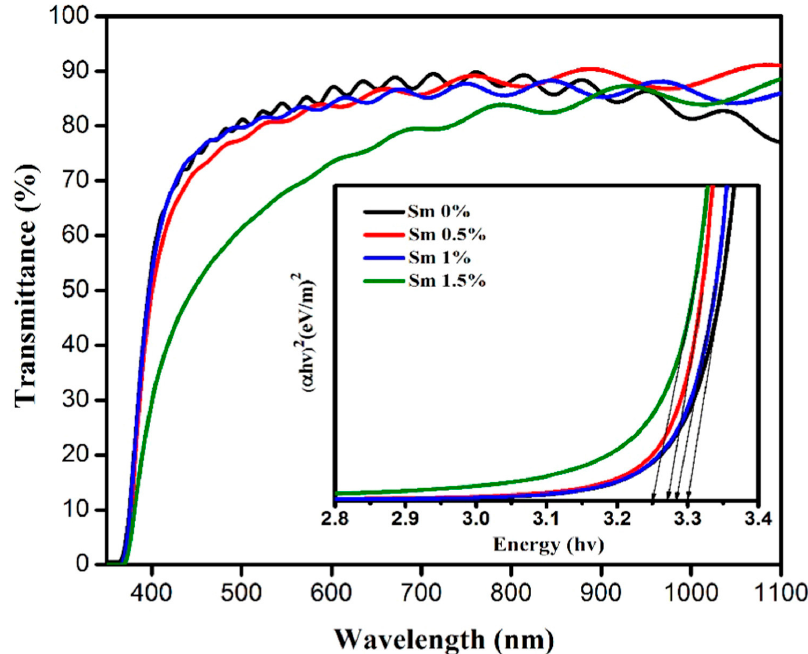
Figure 9. Optical transmittance of Sm:AZO thin films with different co-doping levels (inset of figure), showing the relationship of ( α h υ ) 2 and h υ of Sm:AZO thin films with different co-doping levels. Reproduced with permission from ref. [12].